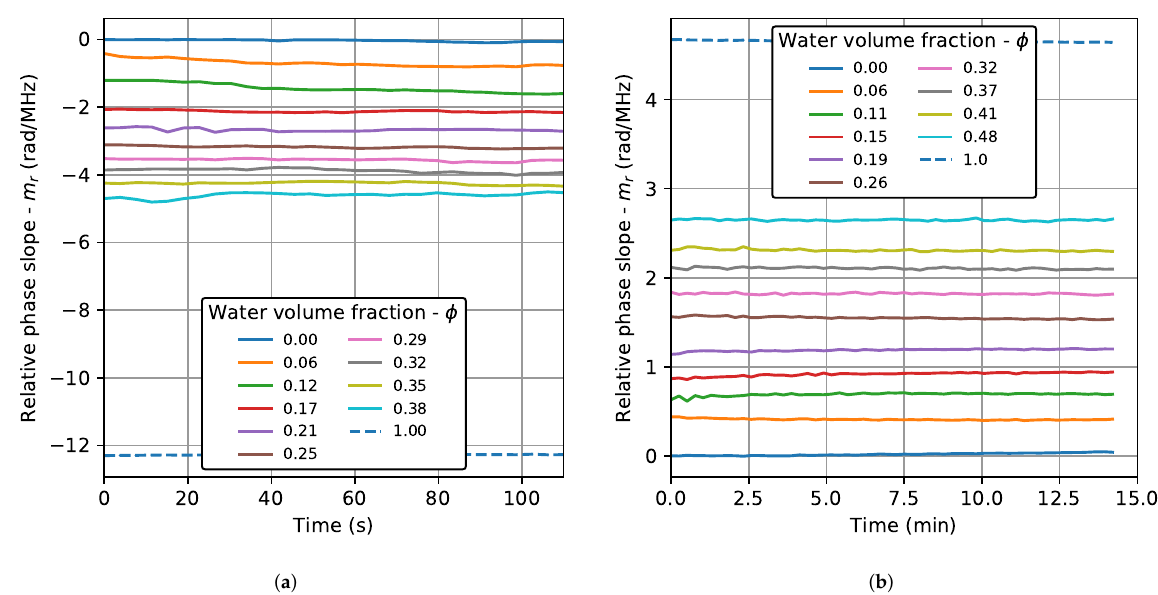
Figure 4. Relative phase slope as a function of the test time for all the concentrations at 30 ◦ C: transmission–reception (TRD) and backscattering (BSD) cases. ( a ) TRD. ( b ) BSD.